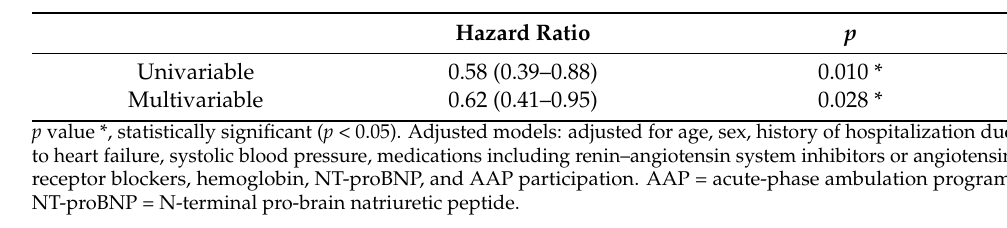
Table 2. Univariate and multivariate Cox regression hazard models for rehospitalization and all-cause death in patients who participated in